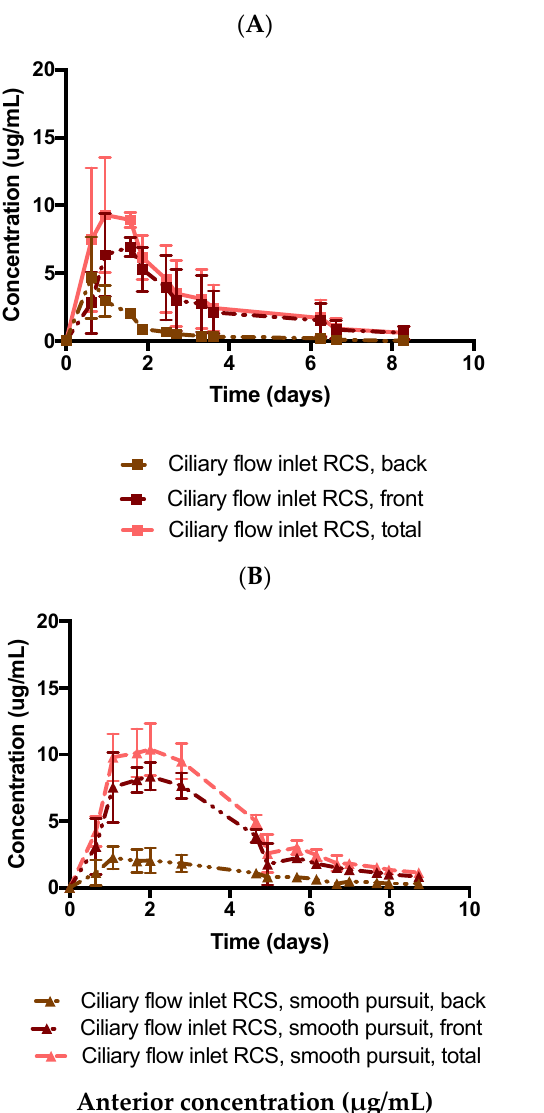
Figure 9. Effect of dexamethasone (0.1 mg, 100 µL) release from the ciliary flow inlet RCS model (2 outlets) ( A , A1 ) without and ( B , B1 ) with slow pursuit movement in PBS, pH 7.4. All data are presented as the mean (n = 2) and standard deviation (±STD).